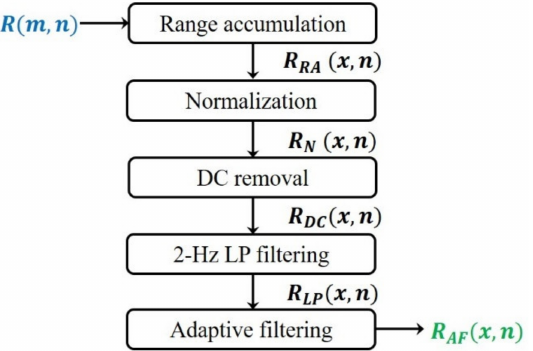
Figure 2. Flow chart of the signal preprocessing steps (DC, direct current; LP,